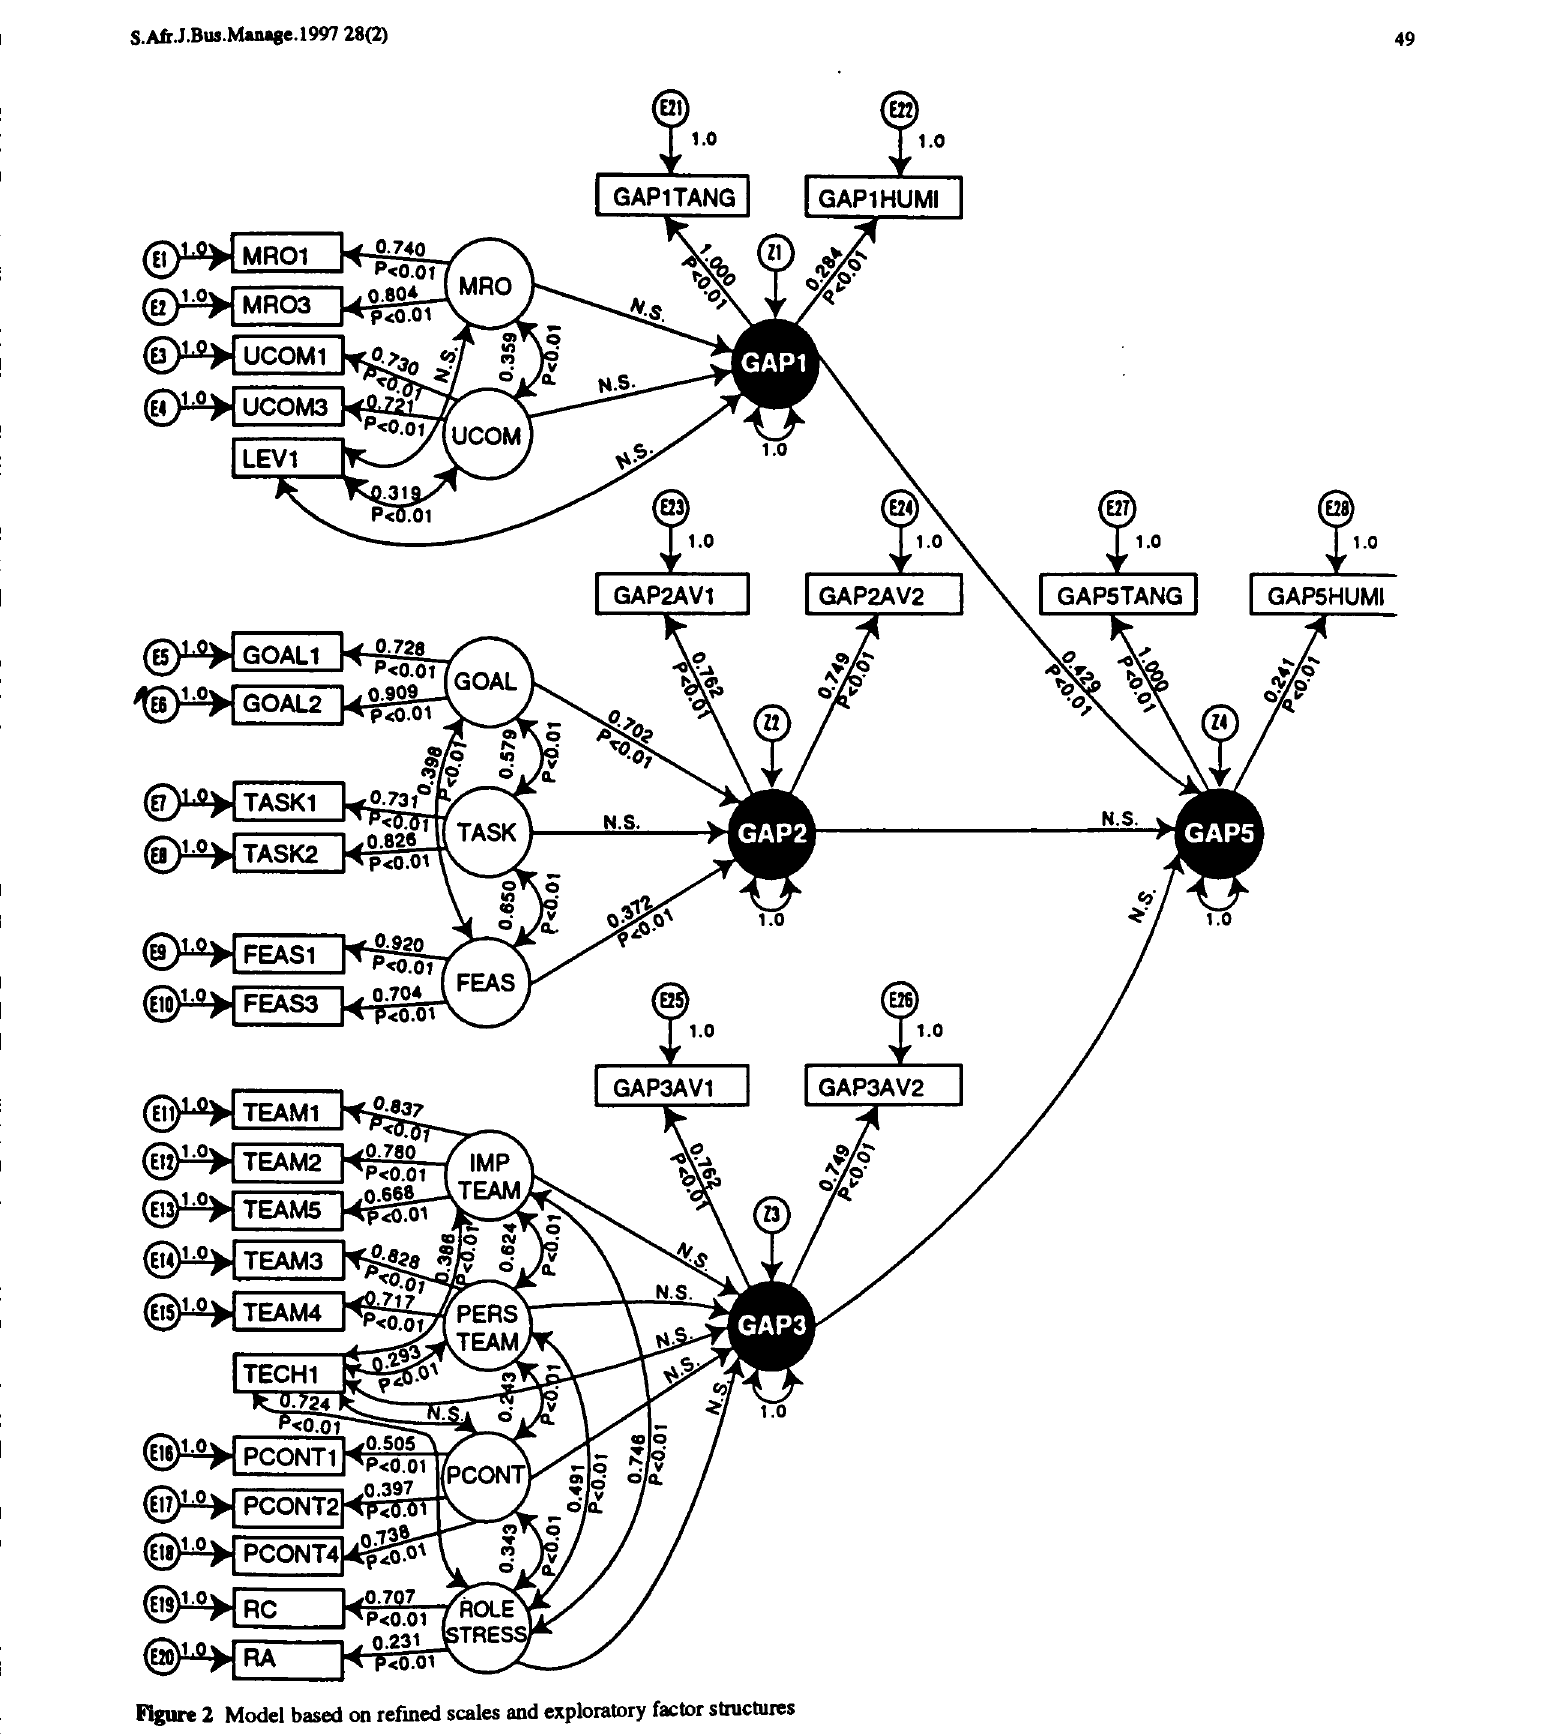
F1gure 2 Model based on refmed scales and exploratory factor